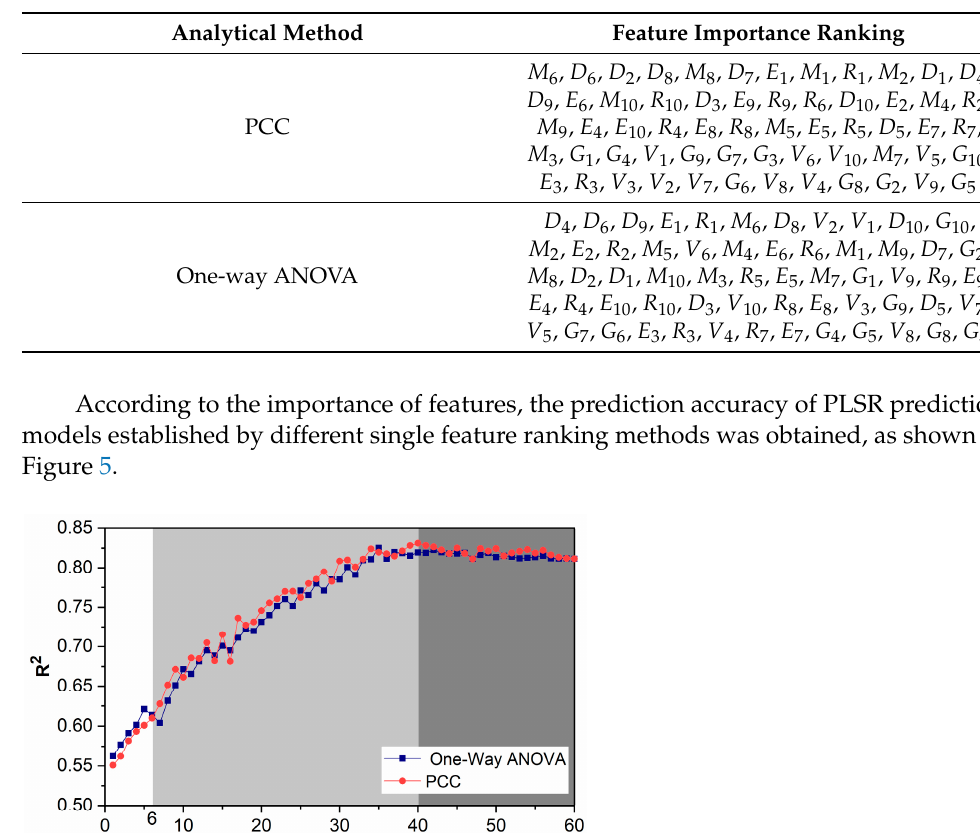
Table 3. Feature importance ranking in single feature ranking methods.